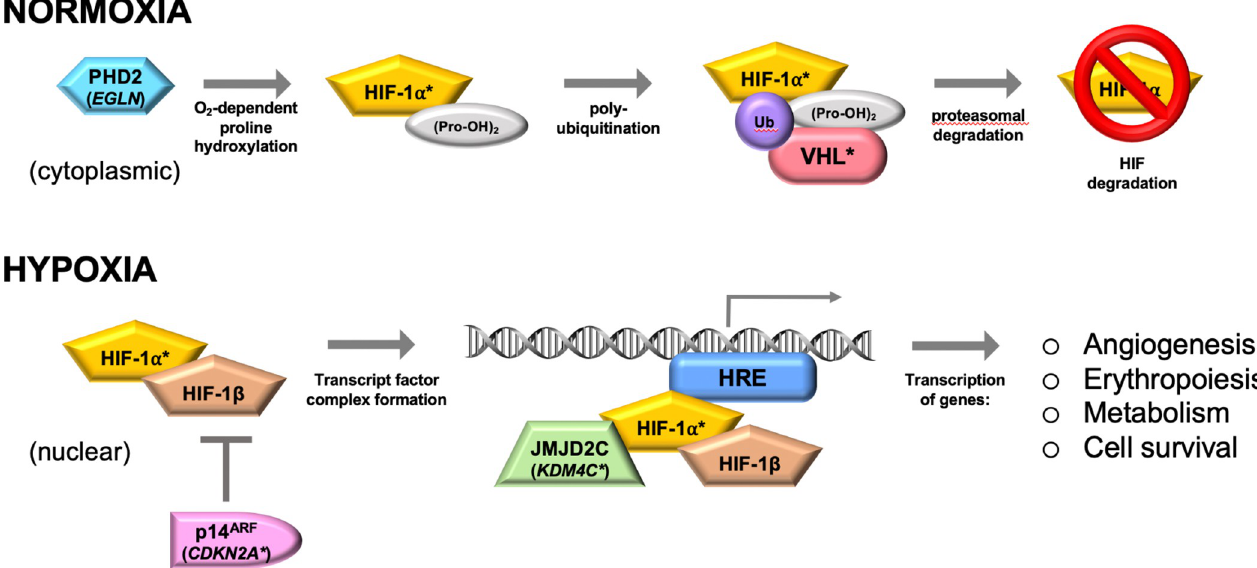
Fig 4. Regulation of HIF-1 α degradation at normoxia and hypoxia. Asterisks denote genes found mutated in probands with OD or MS in this study.